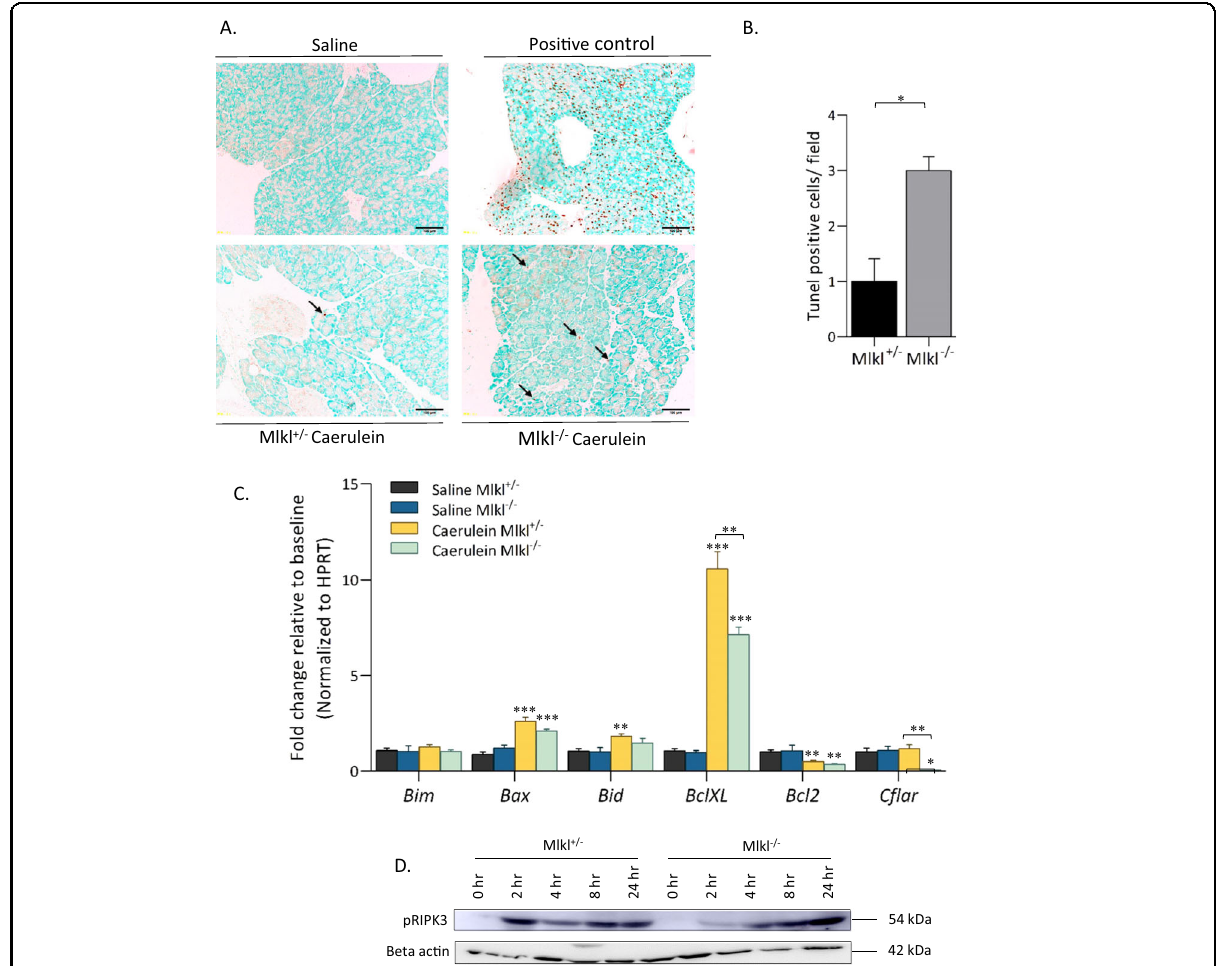
Fig. 7 Caerulein-induced AP leads to a higher level of apoptosis in Mlkl − / − mice than in Mlkl + / − mice. Pancreatic apoptosis was detected by terminal deoxynucleotidyl transferase dUTP nick end labeling (TUNEL) staining. A Representative images of TUNEL-stained pancreatic sections from Mlkl − / − and Mlkl + / − mice treated with either saline or caerulein. Pancreatic sections were incubated with DNase I as a positive control ( B ). The number of TUNEL-positive cells per fi eld. C qPCR analysis of the mRNA expression of proapoptotic genes ( Bim , Bax , and Bid ) and antiapoptotic genes ( BclXL , Bcl2 , and C fl ar ) in pancreatic tissue after 12 h of treatment with saline or caerulein ( n = 6 in each group). D Kinetics of pRIPK3 during the course of cearulein treatment, mouse pancreatic tissue was collected at the indicated times and then cell lysates (50 μ g of protein) were analyzed by immunoblotting. The data are presented as the means ± SEMs. * P < 0.05, ** P < 0.01, and *** P < 0.001 compared to the control